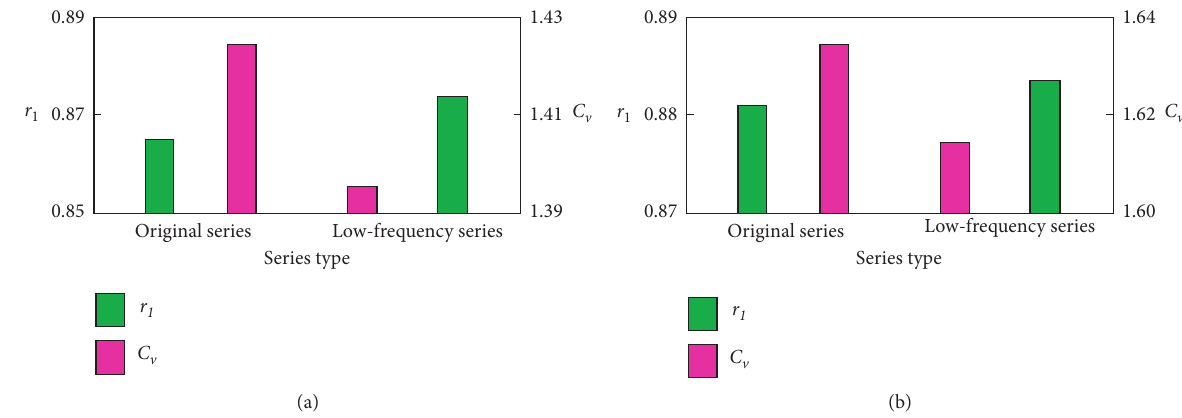
Figure 5: Main characteristic values of corresponding series: (a) sample A; (b) sample